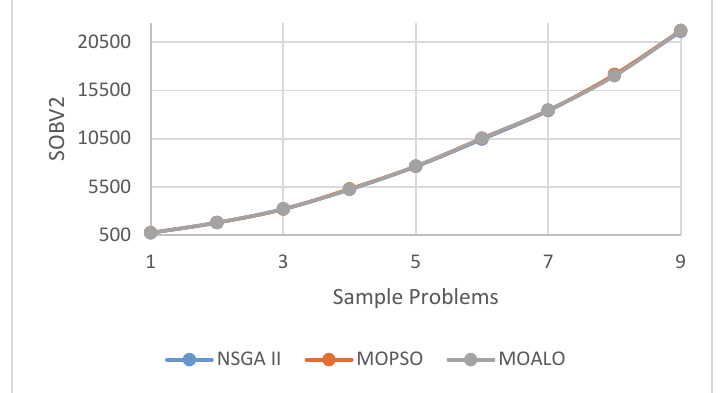
Fig. 17 . Changes in averages of the second objective function in large sample sizes